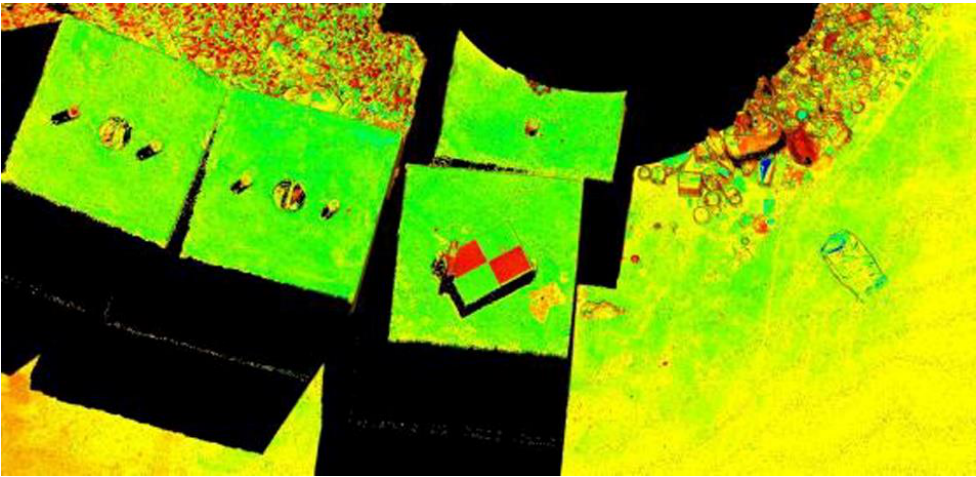
Figure 13. A target identified in the laser scanner model.